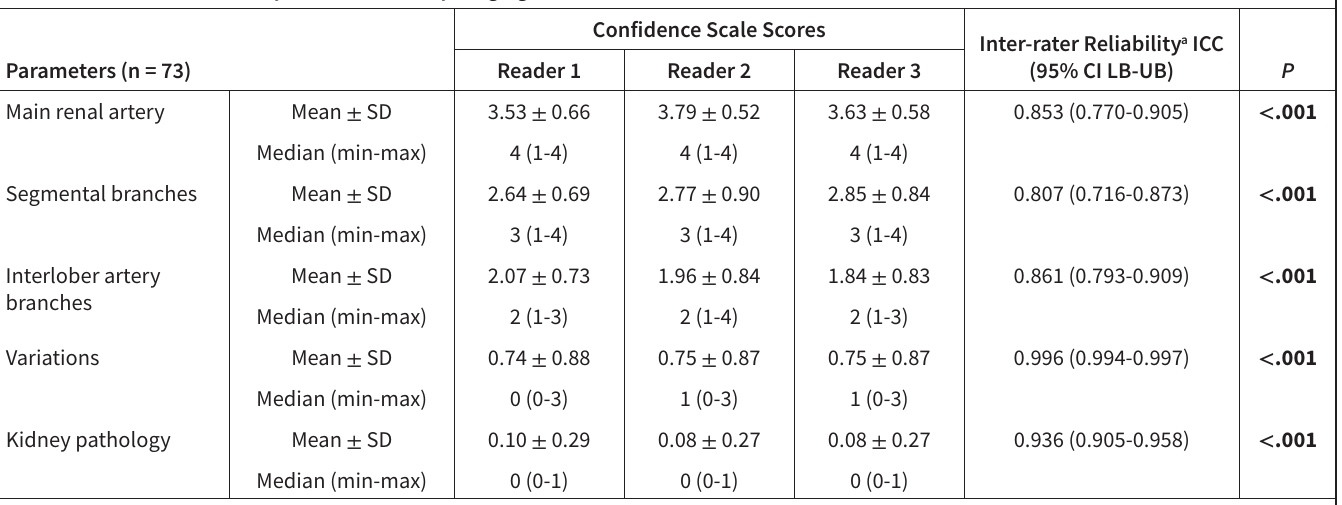
Table 2. Inter-rater Reliability of Several KidneyImaging Scores Between Readers